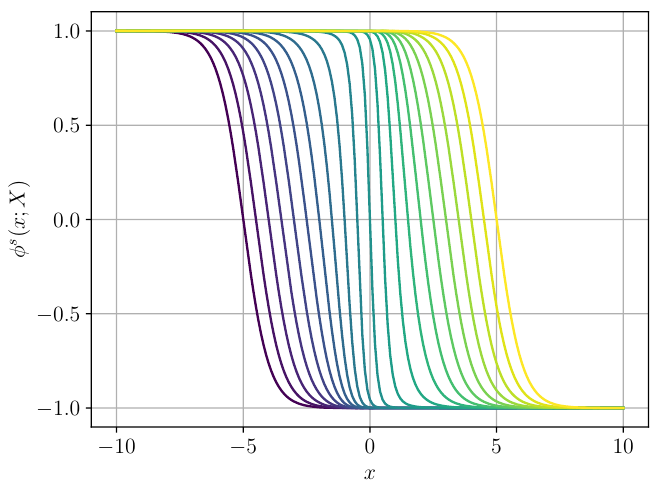
Figure 1 . Evolution of the antikink in X space. We set α = 3 . 0